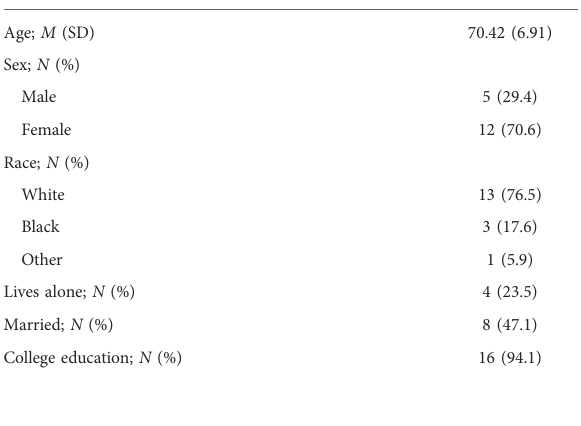
TABLE 2 Demographics for those who completed the qualitative